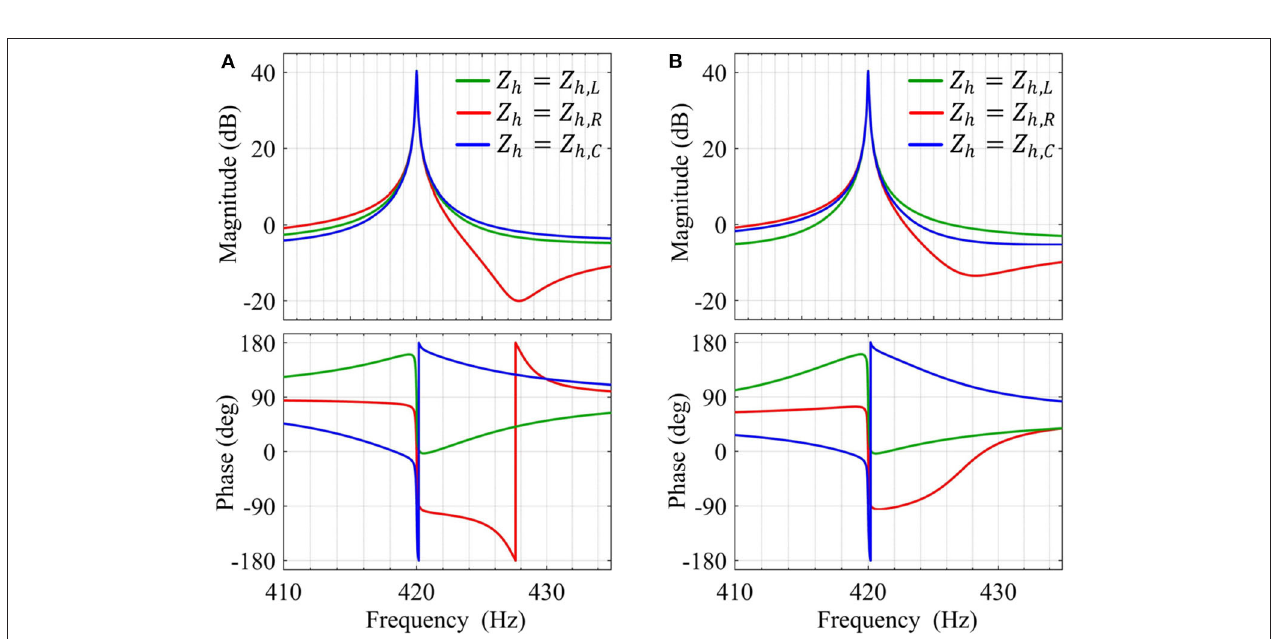
7) of an oscillator-based VSC emulating different types of resonant virtual = 0 and (B) R vir 0.3 (cid:127) . = =